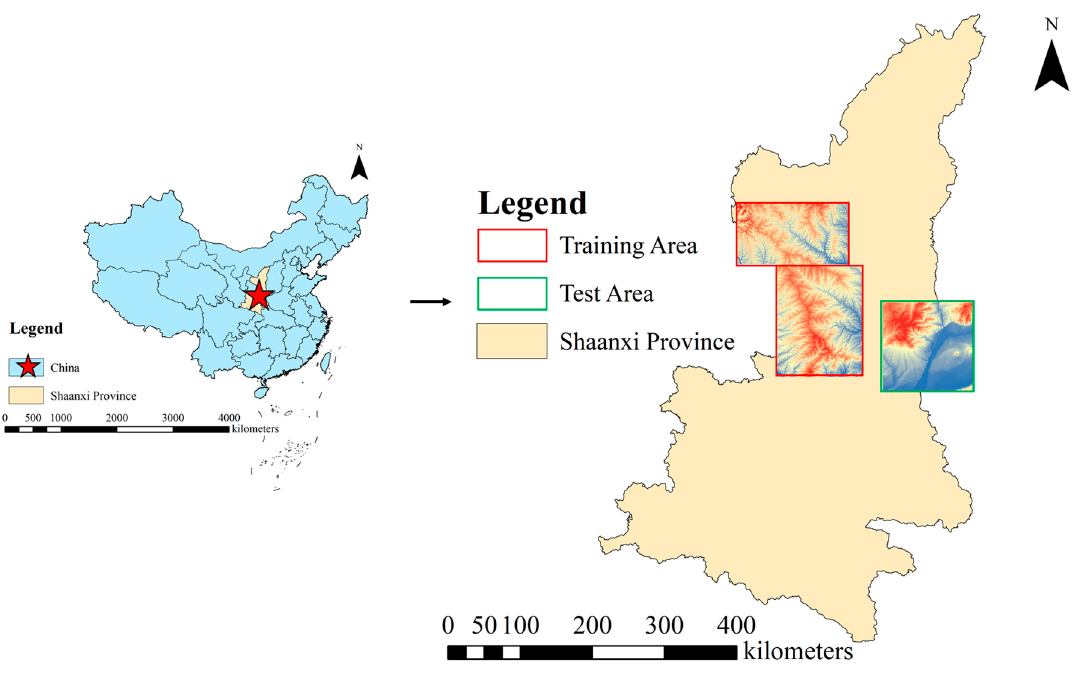
Figure 7. Location of the DEM data in the Loess Plateau study area used for training, validation, and testing.